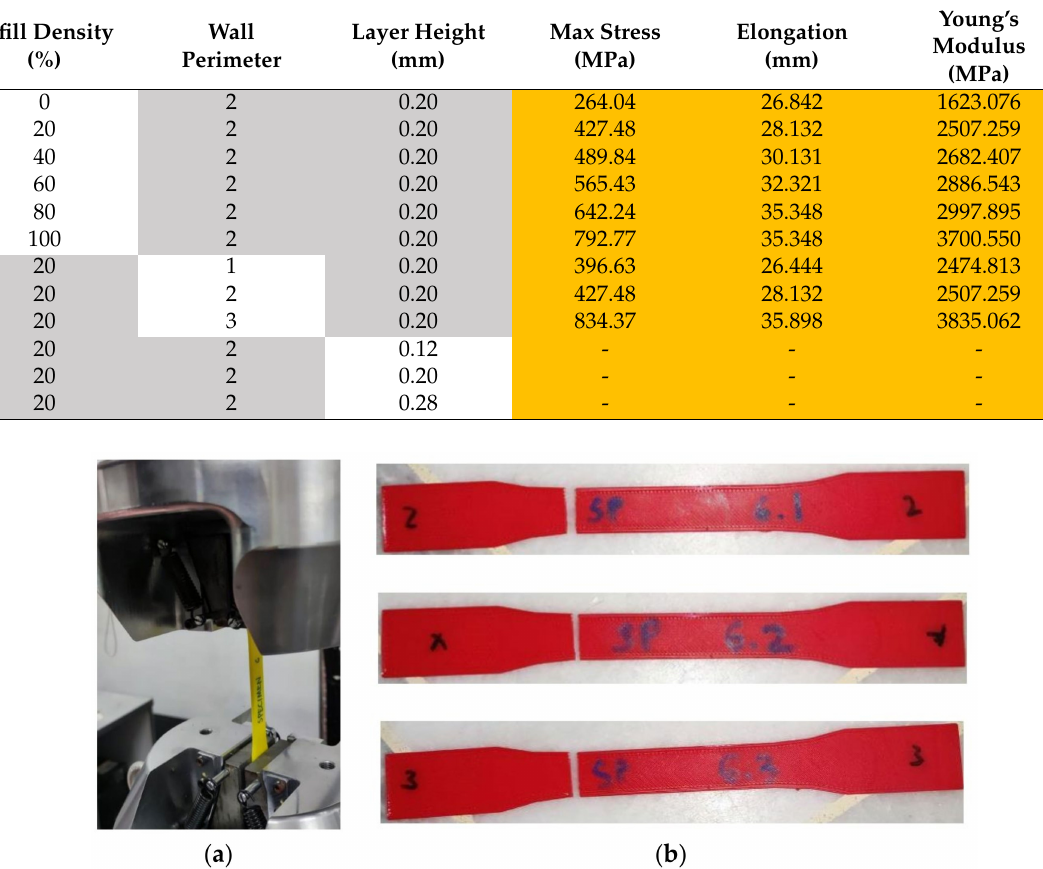
Table 3. Results for the simulation testing.